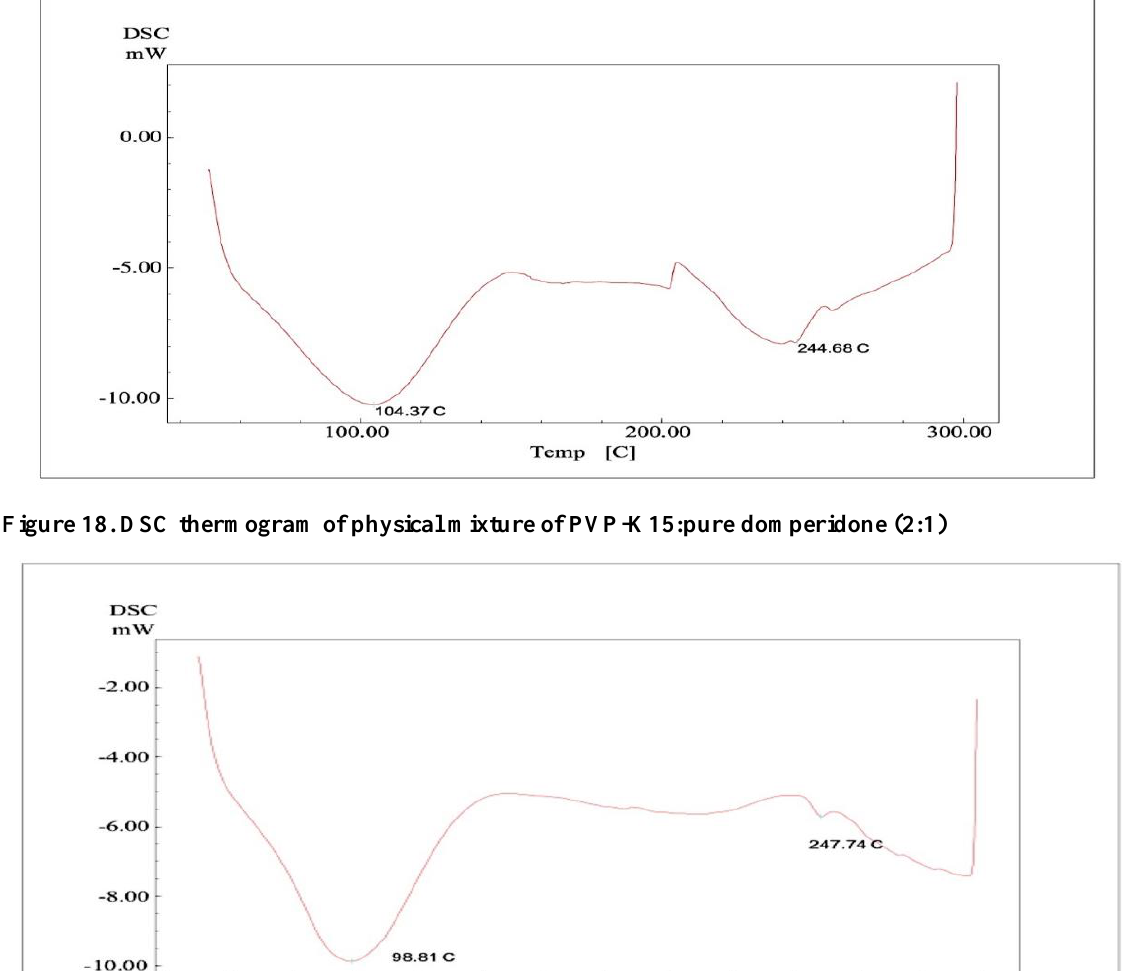
increase in percentage of release of domperidone from nanoparticles was due to the increase in the surface area of these particles (25) and to the reduction in crystalline state of domperidone. These findings support that, the use of precipitation method was efficient and effective in preparing